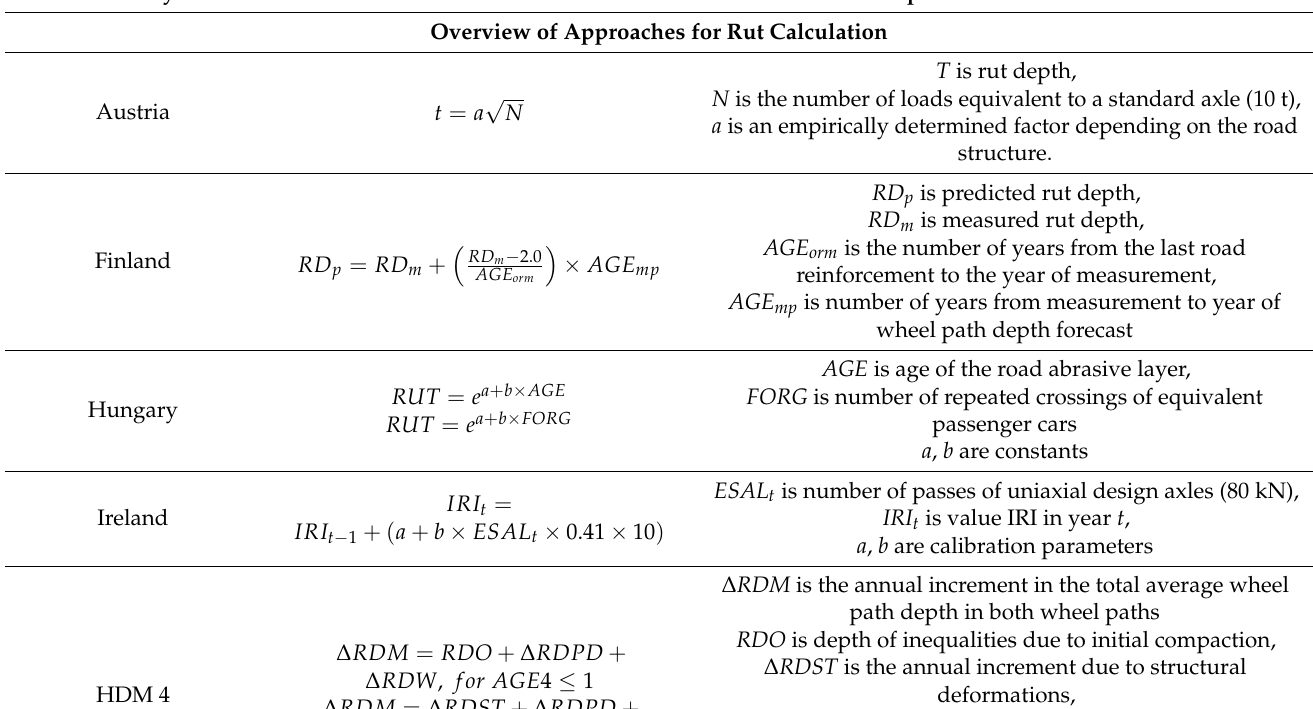
Table 1. Overview of approaches for evaluating the quality of roads and their parameters [24,26].